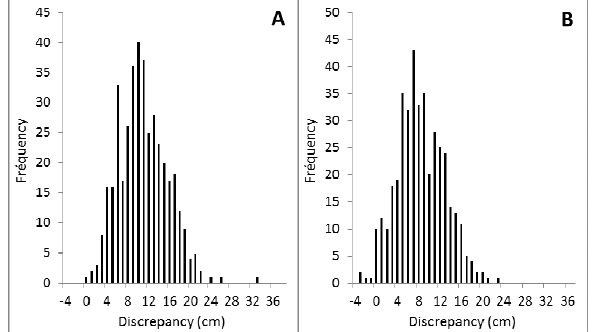
Figure 7. Histograms showing the distribution of discrepancies for different numbers of GCPs (A: DSM 1-7; B: DSM 1-19) To know the ability of DSMs to create points corresponding to reality, a scatter (XYZ) plot was carried out between GNSS profile and DSMs extracted profiles. Except for DSM 1-4, the coefficients of determination (R²) are close to 1: from 0.958 for DSM 1-5 to 0.973 for DSM 1-14 (Figure 8). The bias is Figure 5. Ellipsoidal heights of GNSS profile and DSMs extracted profiles